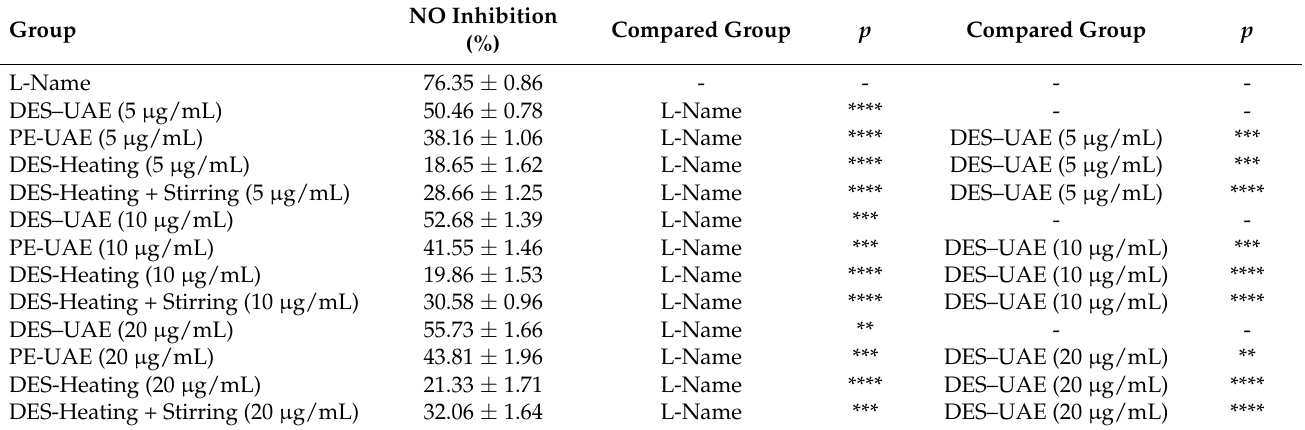
Table 7. The NO inhibition of the extracted macamide products in LPS-stimulated RAW264.7